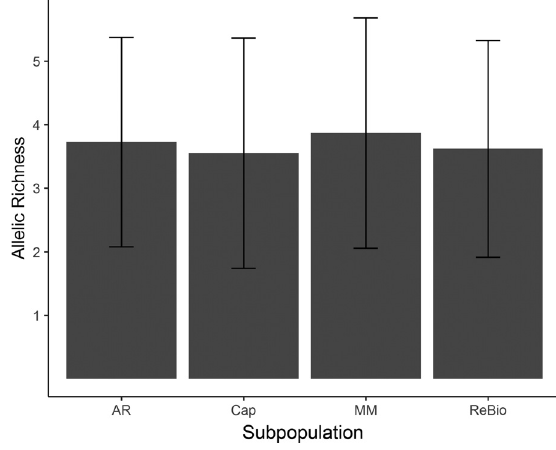
Figure 2 - Allelic richness with standard deviation values for E. ovata subpopulations with nSSR markers.